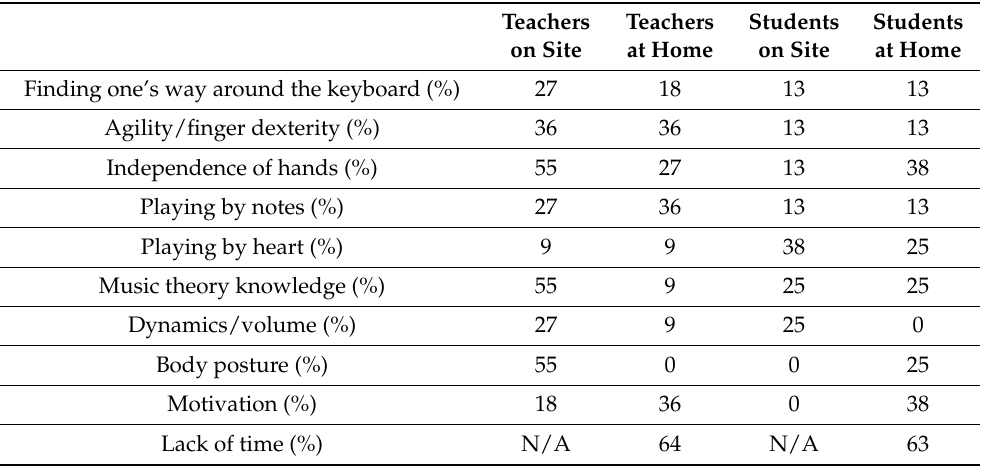
Table 2. Reported problems during piano lessons and during independent home practice. Teachers’ and students’ responses presented as percentages. Multiple responses were